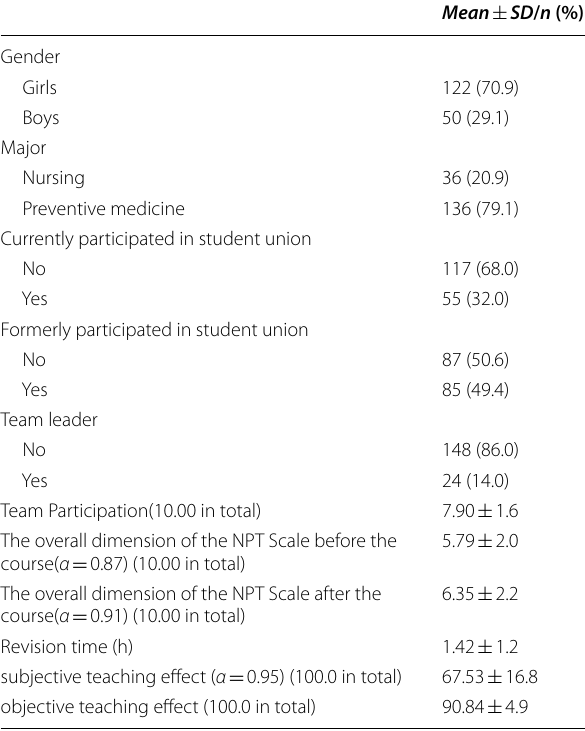
Table 1 Characteristics of Participants ( n